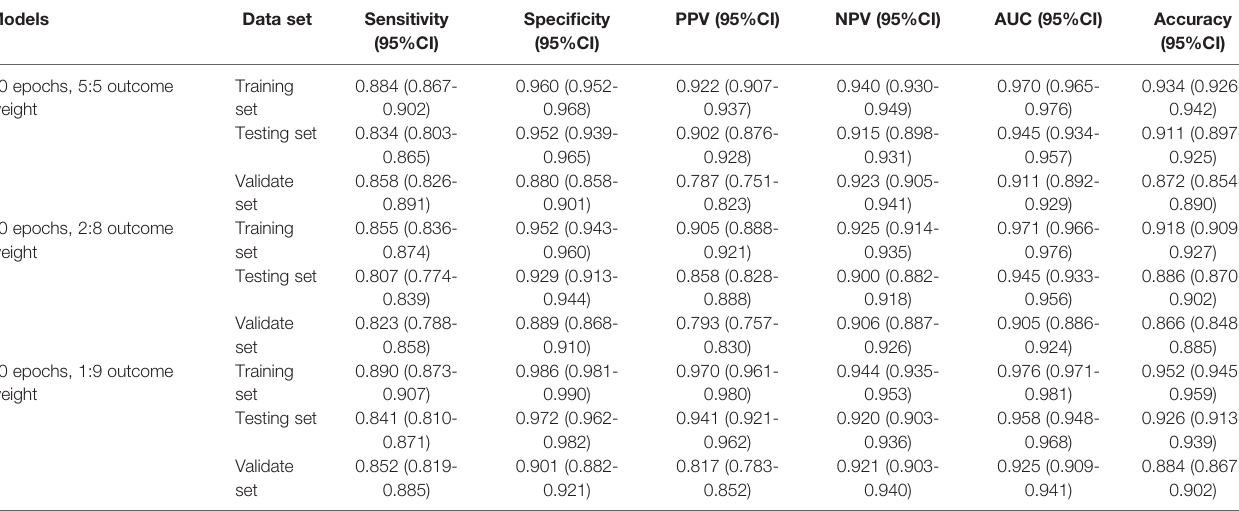
TABLE 3 | The performances of the AA, MDS, and AML three-classi fi cation model with different outcome weights.